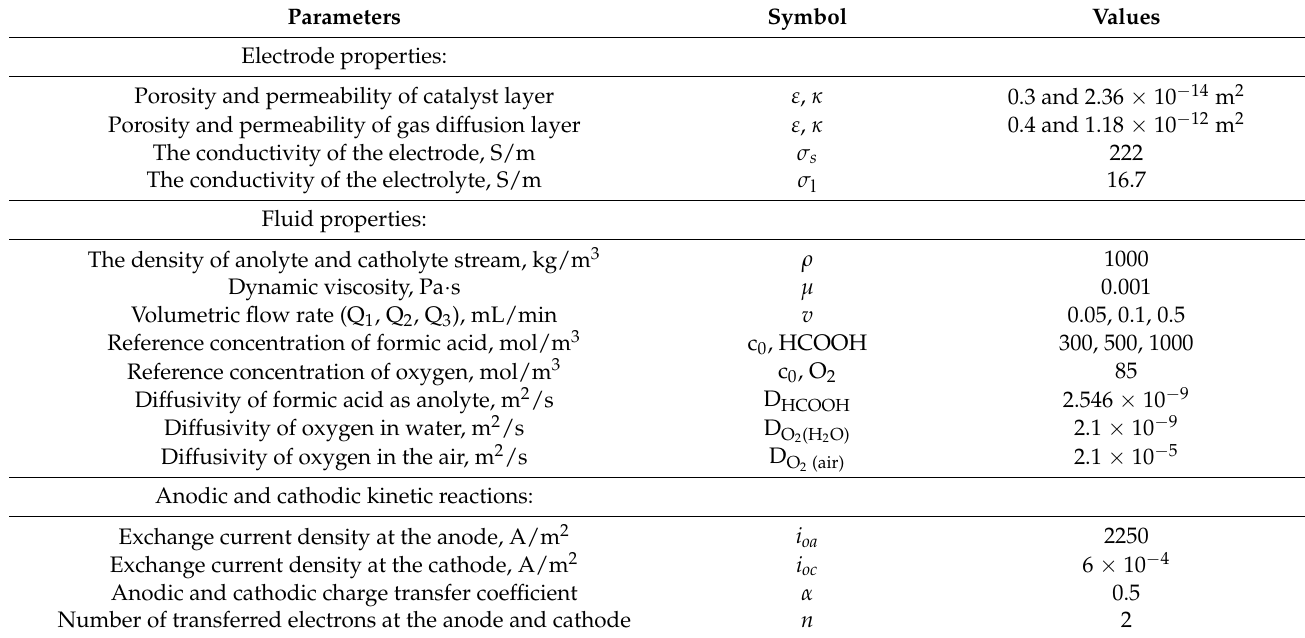
Table 1. The physical/transport properties used in the model for numerical